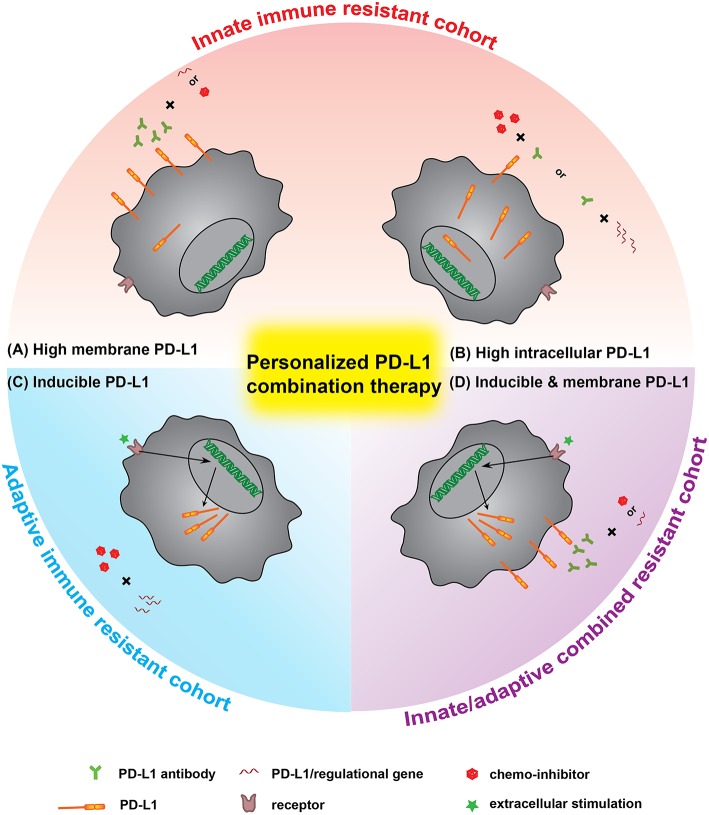
The personalized PD-L1 combination therapy, a prospect of optimal PD-L1 immunotherapy guided by PD-L1 distribution and immune resistance of patients. Innate immune resistant cohort: (A) for cells with high constitutive mPD-L1, the regimen would mainly rely on antibody blockade while the combination of gene silencing or chemical inhibitor would benefit the treatment. (B) For cells with high intracellular PD-L1, the regimen should more rely on gene knockdown or inhibition method, supported by PD-L1 antibody. Adaptive immune resistant cohort: (C) the inducible PD-L1 is much easier to be controlled by gene silencing and chemical inhibitor combination therapy. Combined immune resistance cohort: (D) for cells with both high constitutive and inducible PD-L1, the regimen would be better to choose the combination of antibody + gene silencing or antibody + chemical inhibitor.